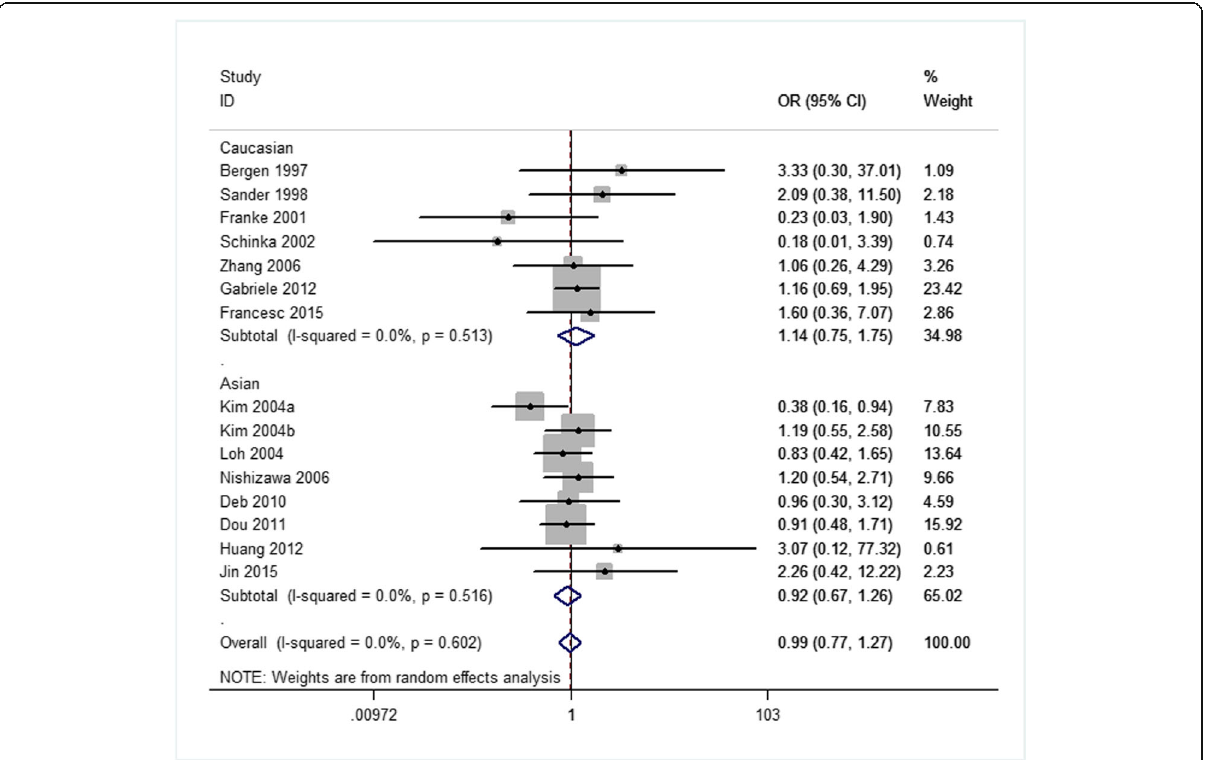
Fig. 7 Forest plots (individual and pooled effects with 95% CI) regarding the association of the OPRM1 A118G polymorphism with alcohol dependence in the recessive